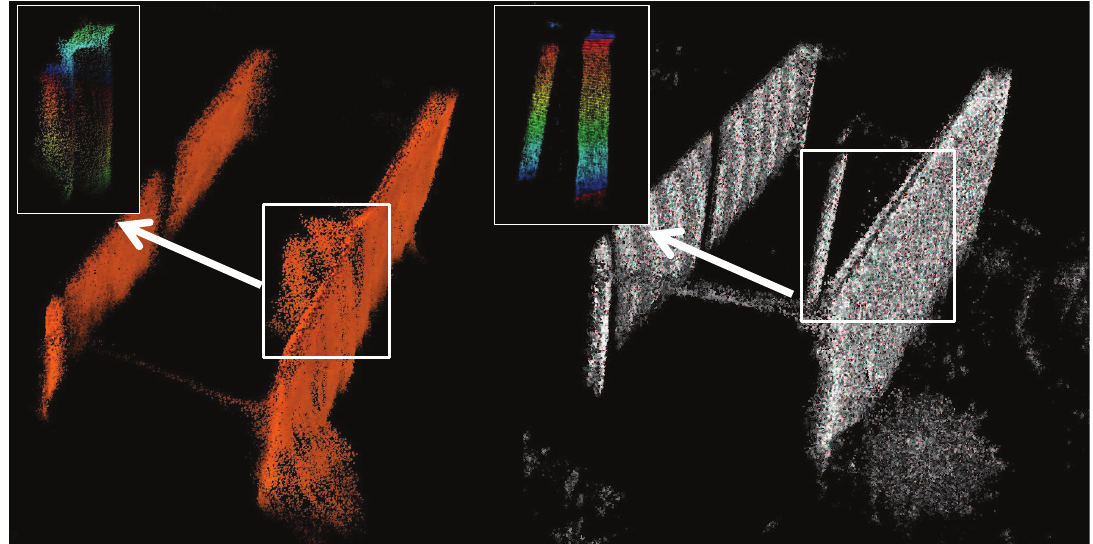
Figure 2: (Top) Point clouds of Target 1 from (left) VZ-400 and (right) HRS-3D. Insets show chosen point cloud subsets for further analysis.